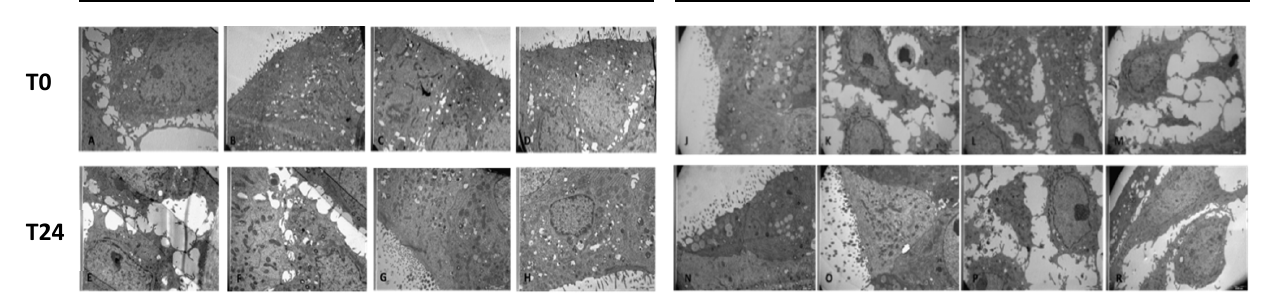
Figure 10. Upper panels : Epiderm morphology analyzed by TEM microscopy. ( Left panels : A – D ): TEM images of Epiderm tissues exposed to air (T0h); basal layer with large intercellular spaces, compact inner layer cells; stratum corneum without discontinuity; ( E – H ): TEM images of Epiderm tissues exposed to air (T24h); basal layer with large intercellular spaces, cells often vacuolized, loss of adhesion with the support; cells of the inner layers appear compact and stratum corneum compacted in many places, 5K magnification; ( Right panels : A – D ): TEM images of Epiderm tissues exposed to 300 ppm HOCl (T0h); compact basal layer and also inner layers; thick horny layer; ( E – H ): TEM images of Epiderm tissues exposed to 300 ppm HOCl (T24h); basal layer with large intercellular spaces, some vacuolized cells, detached from the support cells of the compact inner layers; stratum corneum with little areas of detachment, 5K magnification; Below panels : Epiairway morphology analyzed by TEM microscopy. ( Left panels: A – D ): TEM images of Epiairway tissues exposed to air (T0h); cells appear functionally normal, nuclei, mitochondria and surface normal; there is large intercellular spacing and some cells with numerous electron-dense lysosomal granules; ( E – H ): TEM images of Epiairway tissues exposed to air (T24h); basal cells with large intercellular spaces, detached from the support many in various necrotic steps, mitochondria dense with deposited material, superficial cells with less damaged but often vacuolized organelles rich in secretory granules, 5K magnification. ( Right panels: J – M ): TEM images of Epiairway tissues exposed to 300 ppm HOCl (T0h); the